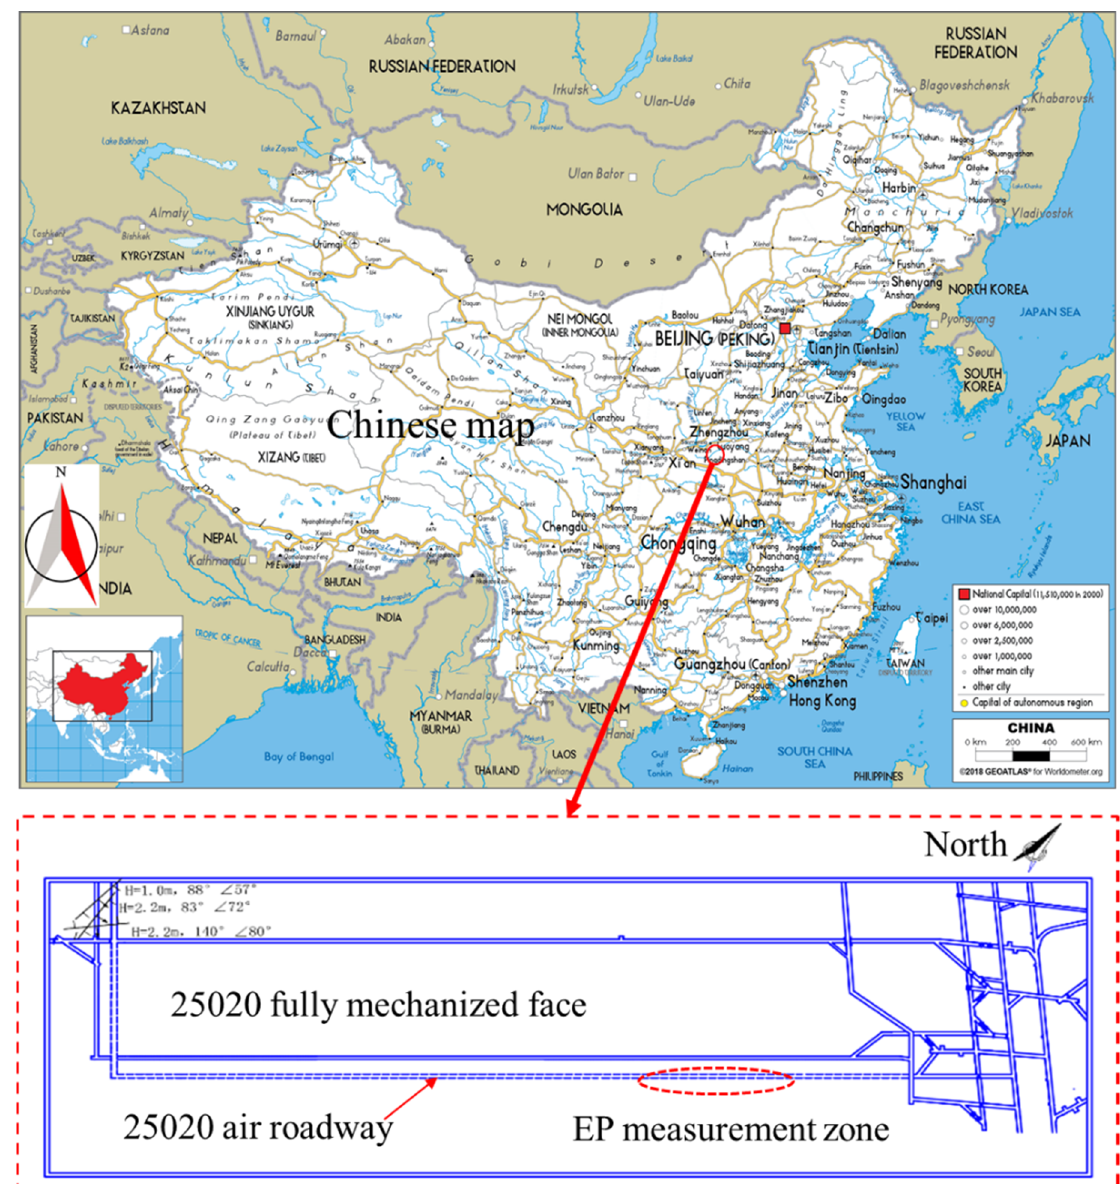
Figure 1. Schematic diagram of EP measurement zone in 25,020 Air Roadway, Xuehu Coal